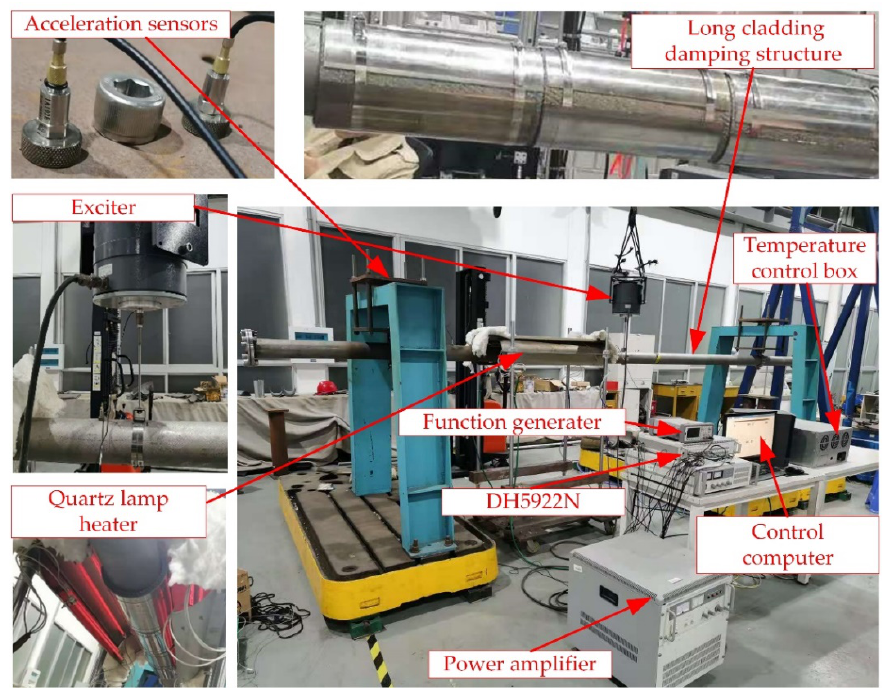
Figure 7. The thermal–vibration joint test system.